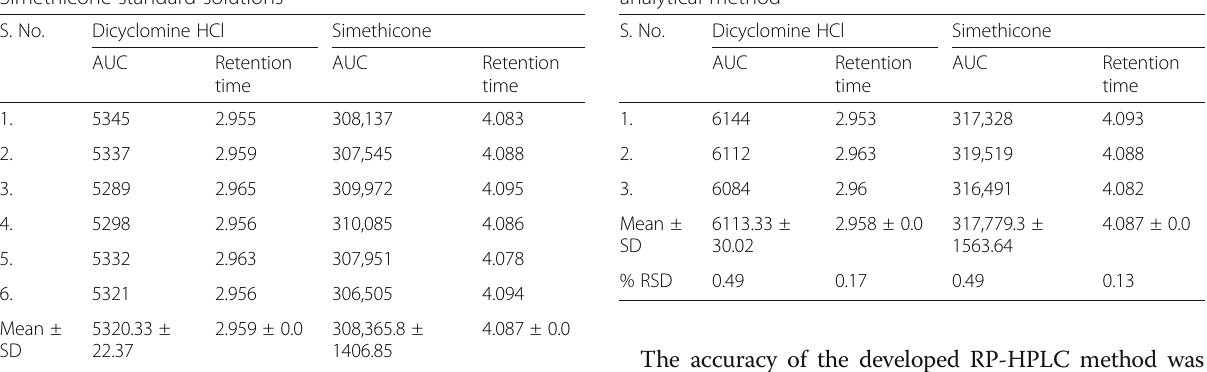
Table 7 Repeatability study of inter-day samples for developed